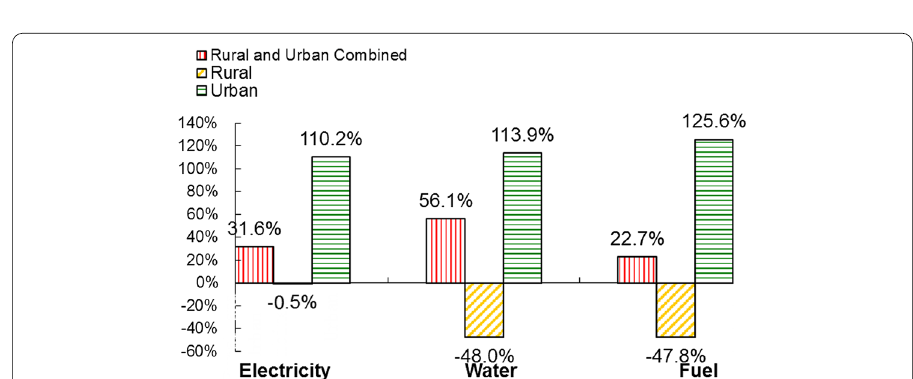
Fig. 5 Relative increase of residential energy demands in 2050 as compared to 2010, classified by rural and urban